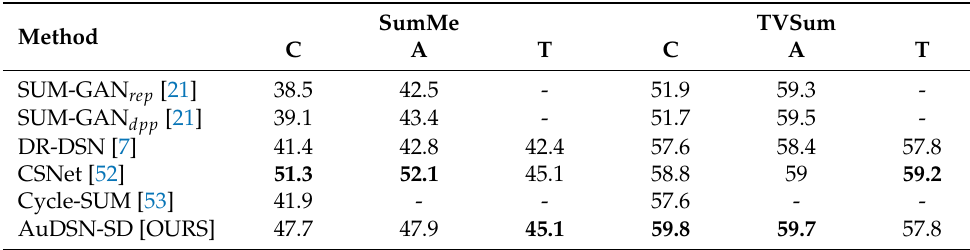
Table 6. F-score (%) of the LSTM-based approaches on SumMe and TVSum in the canonical (C), augmented (A), and transfer (T) settings.